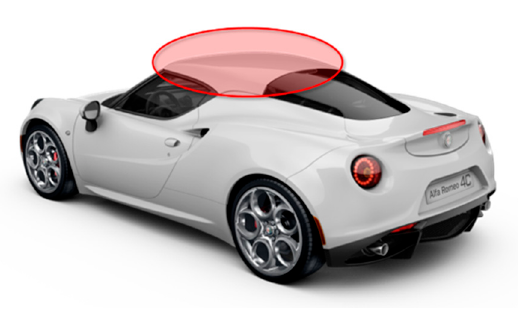
Table 1. Mesh details and mass of 4C car model . Figure 7. Alfa Romeo 4C car, with highlight of the roof. Figure 7. Alfa Romeo 4C car, with highlight of the roof.